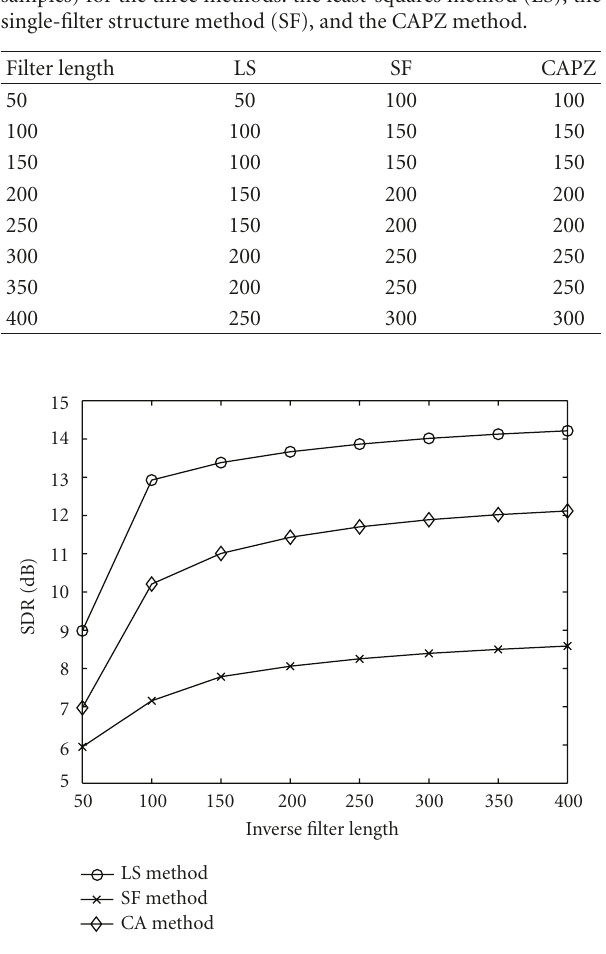
Figure 3: Mean signal-to-distortion ratio (SDR) at di ff erent inverse filter lengths for the three methods: the least-squares method (LS), the single-filter structure method (SF), and the CAPZ method.